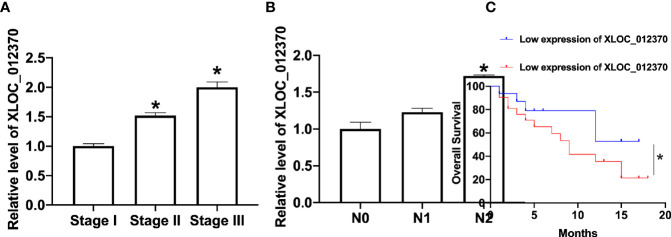
Associations between XLOC_012370, clinicopathologic characteristics, and prognosis after surgery. (A) XLOC_012370 expression in different TNM stages of pancreatic cancer, stages I, II, and III (n = 13, n = 9, and n = 8, respectively). *P < 0.05. (B) XLOC_012370 expression in the lymph node metastasis-N0 group (N0, n = 7), -N1 group (N1, n = 9), and -N2 group (N2, n = 6). *P < 0.05. (C) Overall survival curve of the high-level and low-level group divided by XLOC_012370 expression. *P < 0.05.